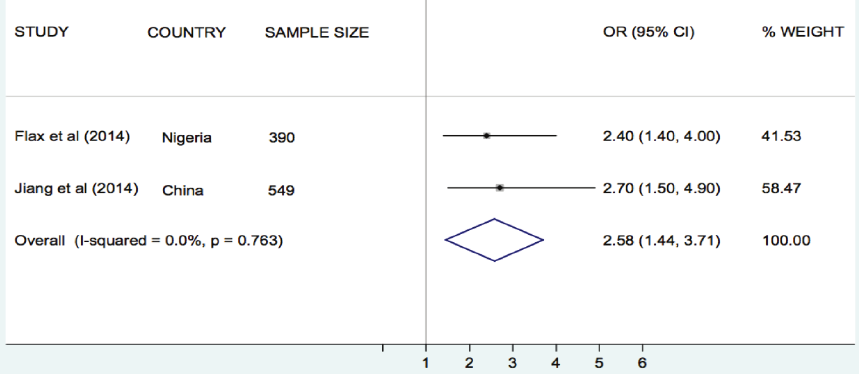
Figure 6. Meta–analysis of the effect of SMS/cell phone intervention vs routine prenatal care on exclusive breastfeeding for six months based on three RCT undertaken in Nigeria and China: OR represents the odds ratio of